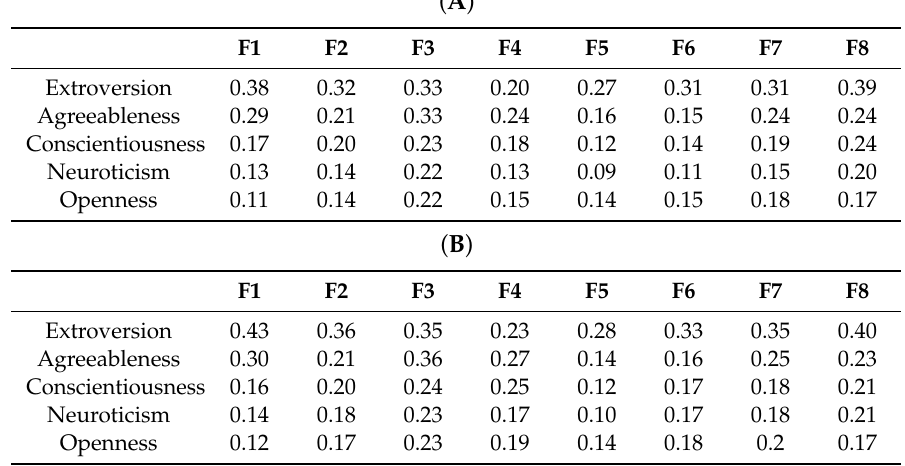
Table 4. ( A ) Coe ffi cients of the correlation between the eight Power to Live factors (short-form scores) and Big Five personality factors. ( B ) Coe ffi cients of the correlation between the eight Power to Live factors (long-form scores) and Big Five personality